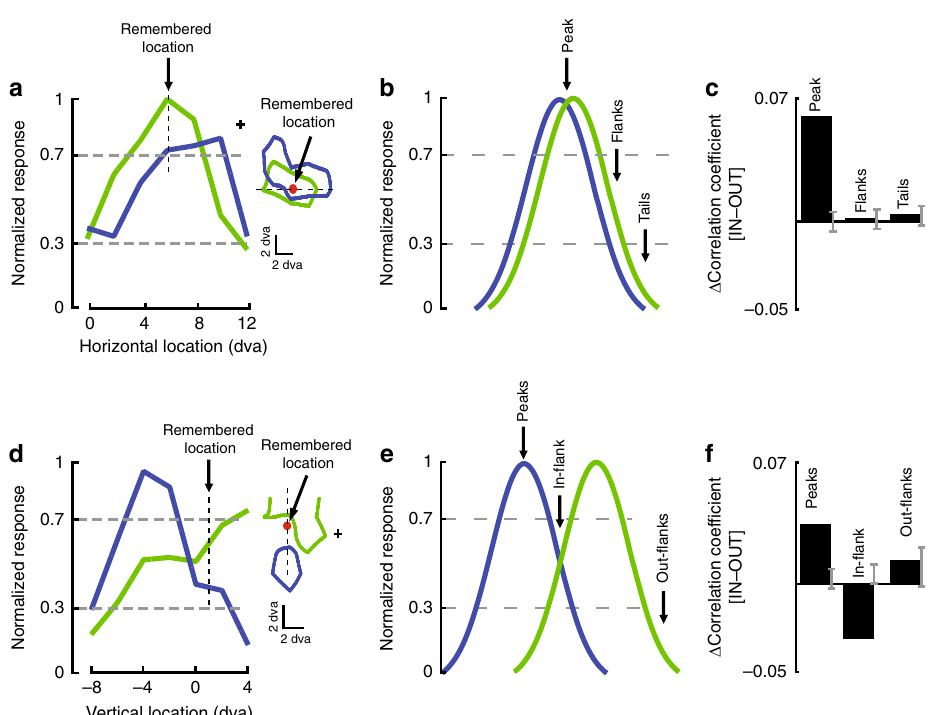
Fig. 2 Changes in noise correlations during WM depend upon RF overlap and memory location. a RF pro fi les for a pair of example neurons with overlapping RFs. (Left) Firing rate as a function of horizontal location in visual space. The vertical dashed line indicates the remembered location. (Right) RF pro fi les plotted as the 70%-of-max contour in two dimensions. The dashed line indicates the slice used for the 1-dimensional plot to its left, the red dot indicates the remembered location, and the cross indicates fi xation point. b A schematic illustration of the spatial RF pro fi les and WM locations for an overlapping pair of neurons. WM targets could appear near the peak of both RF pro fi les (>0.7, Peak), in an intermediate portion of both RFs (0.3 – 0.7, Flanks), or in an area with little response (<0.3, Tails). Horizontal dashed lines indicate 30% and 70% of maximum normalized fi ring rate. c WM-induced changes in noise correlations for the same example pair of neurons shown in A. We compared the noise correlation for targets in or near the RFs to those appearing in the opposite hemi fi eld (IN – OUT). For this pair of spatially similar neurons, the noise correlation was greater when remembering a Peak location compared to a location outside both ( p = 2×10 − 9 ), but remembering a location in the Flanks or Tails of the pro fi le had no effect (Flanks, p = 0.912; Tails, p = 0.378, Wilcoxon signed-rank test compared to shuf fl ed data; gray bars show SEM for shuf fl ed data). d RF pro fi les for a pair of example neurons with partially overlapping RFs. Conventions as in ( a ). e A schematic illustration of the RF pro fi les and WM locations for a partially overlapping pair. WM targets could appear at the peak of one neuron ’ s RF but outside the other neuron ’ s RF (Peaks), at a location with 0.3 – 0.7 response from both neurons (In- fl ank), or at a location with only some response from one neuron (Out- fl anks). f WM-induced changes in noise correlations (IN – OUT) for the example pair in ( d ). For this pair of partially overlapping neurons, noise correlation decreased when remembering In- fl ank locations ( p = 1×10 − 8 ); Peaks and Out- fl anks memory locations became slightly more correlated (Peaks p = 7×10 − 6 ; Out- fl anks p = their Peak compared to memory OUT ( Δ correlation Peak = 0.060, p = 2×10 − 9 , Wilcoxon signed-rank test compared to shuf fl ed data), whereas no signi fi cant change in correlations occurs when remembering a location in the Flanks or Tails of the RF pro fi les ( Δ correlation Flanks = 0.002, p = 0.912; Δ correlation Tails = 0.005, p = The effect of WM on the correlations between neurons was different for pairs whose RF pro fi les were only partially overlapping, as illustrated in Fig. 2d – f. Figure 2d shows the RF contours for an example partially overlapping pair, and Fig. 2e schematically shows the potential WM locations relative to the neurons ’ RF pro fi les. For pairs of neurons with partially overlapping RFs, we refer to the potential memory locations as Peaks (>70% for one neuron), In- fl ank (30 – 70% for both neurons), and Out- fl anks (<30% for both neurons). For this sample pair we observed a reduction in the noise correlation for the In- fl ank condition and an increase for the Peaks condition, compared to when remembering a location in the opposite hemi fi eld ( Δ correlation In- fl ank = − 0.032, p = 1×10 − 8 , Δ correla- tion Peaks = 0.035, p = 7×10 − 6 , Wilcoxon signed-rank test com- pared to shuf fl ed data). For this example pair, we did not observe